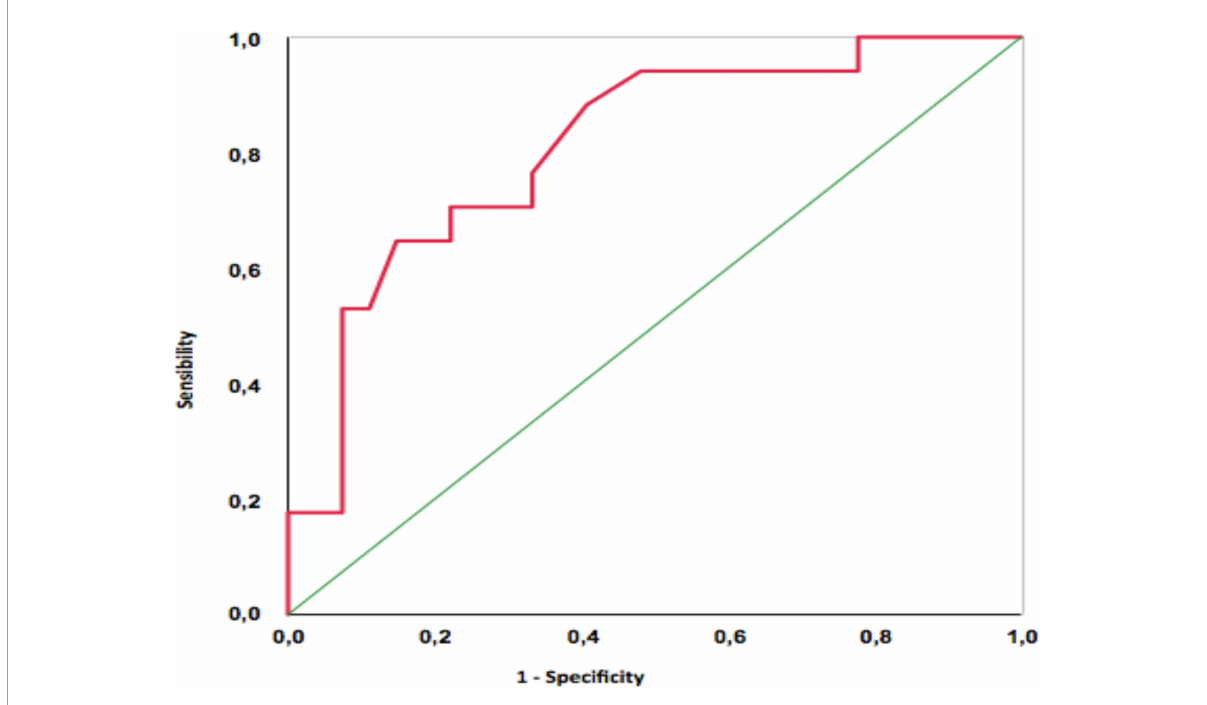
FIGURE2 ROC curve for diagnosis of positive CAC score from the phase angle